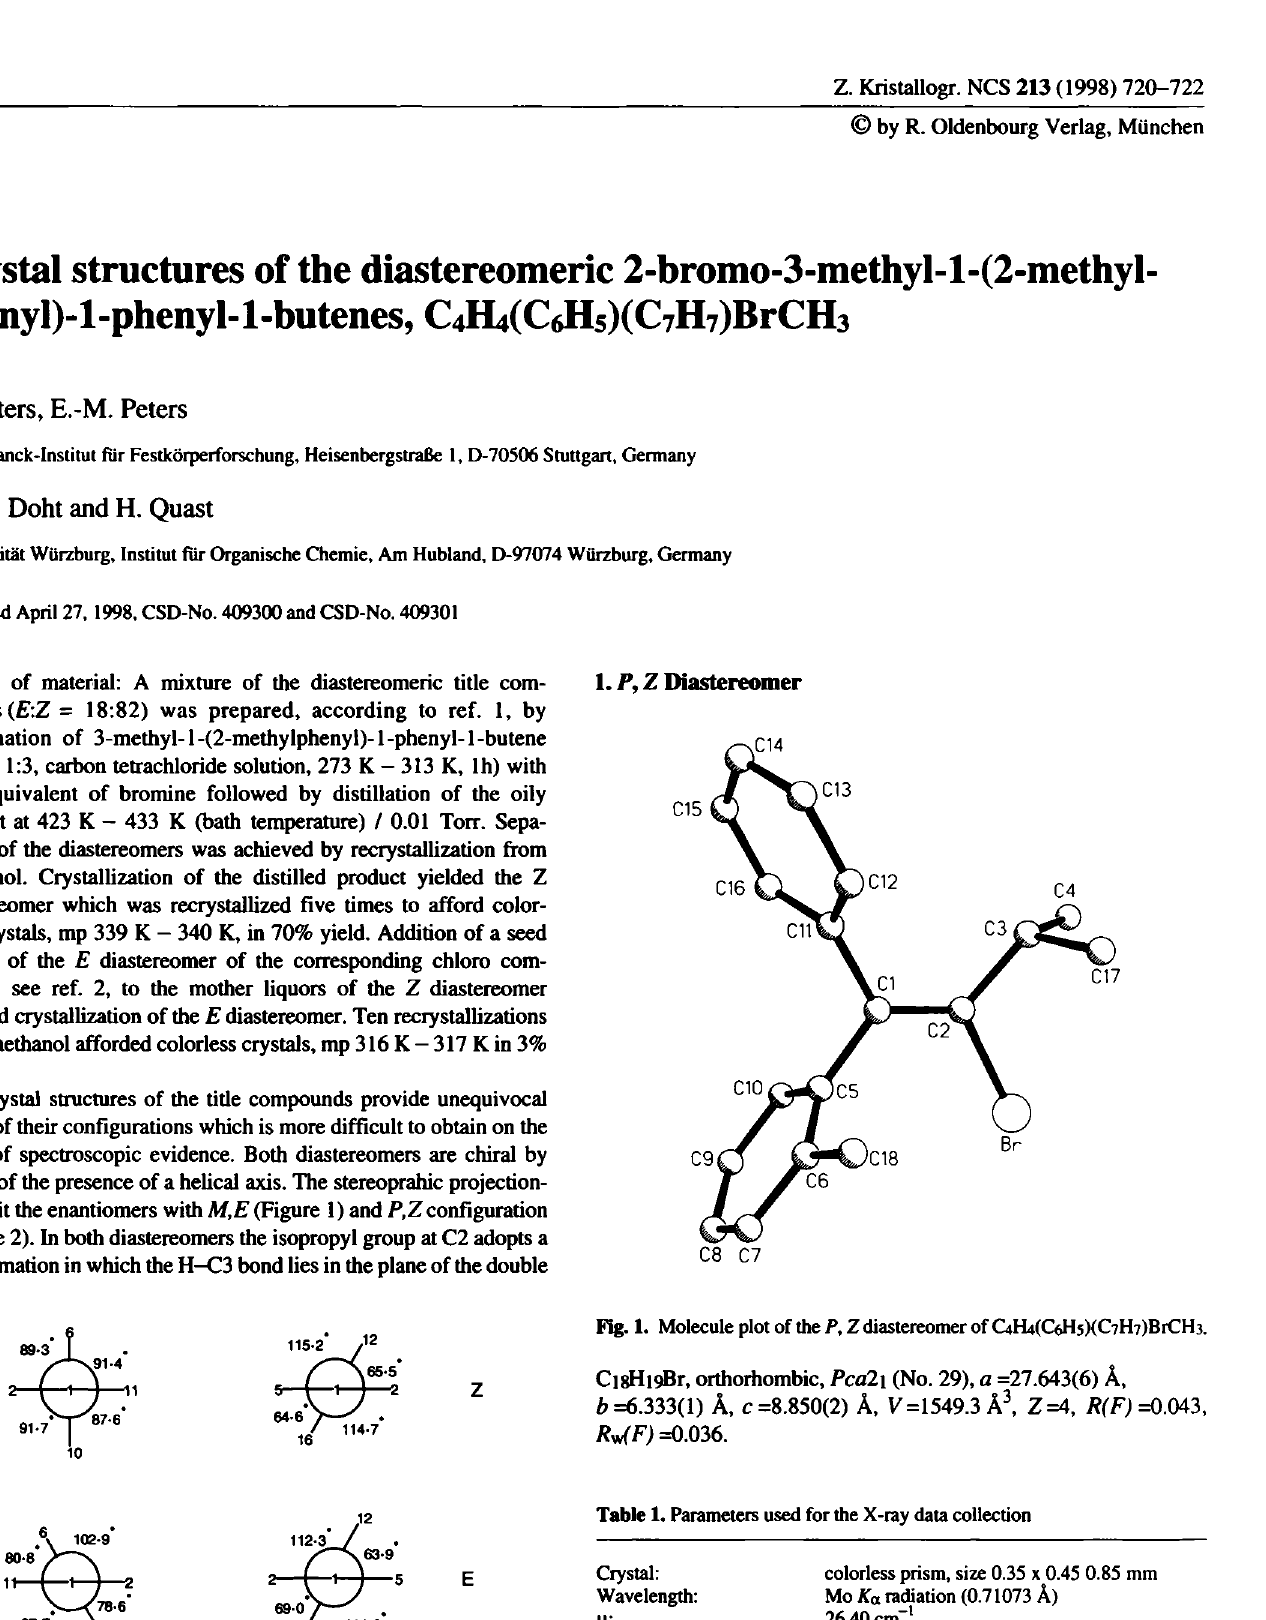
Table 1. Parameters used for the X-ray data